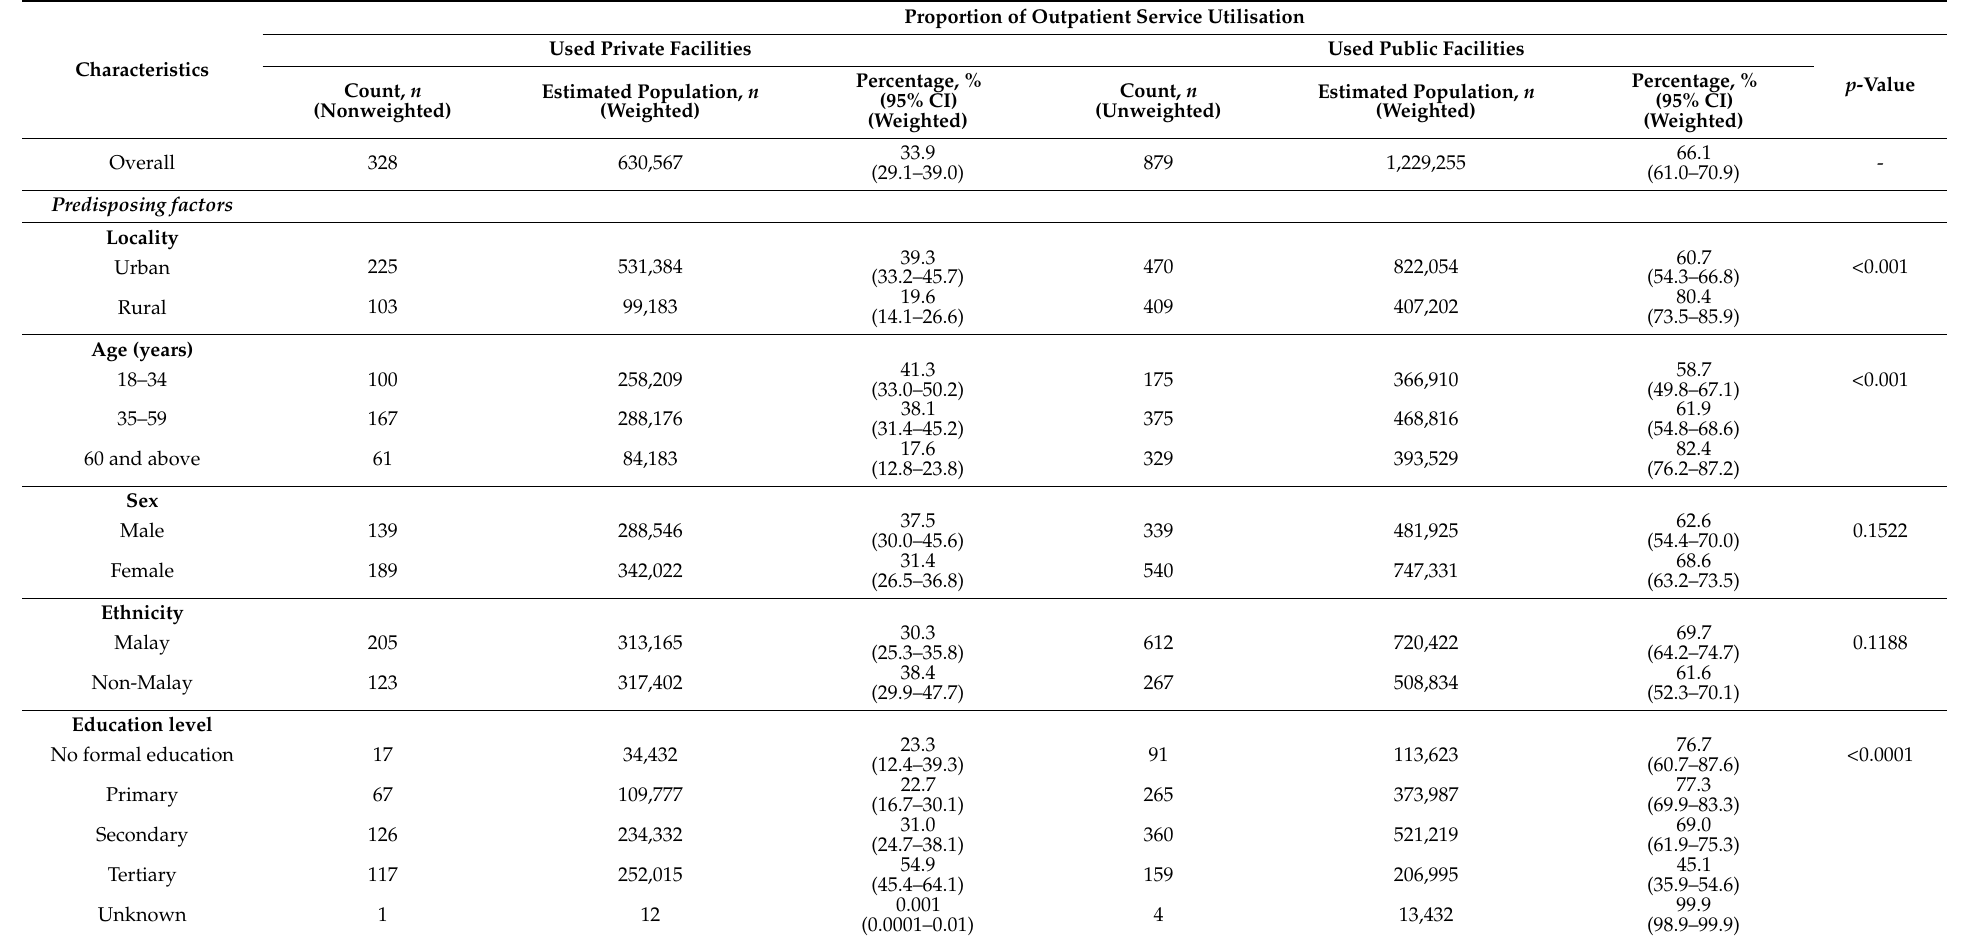
Table 3. Characteristics of the outpatient care users by sector of health care facilities (N =